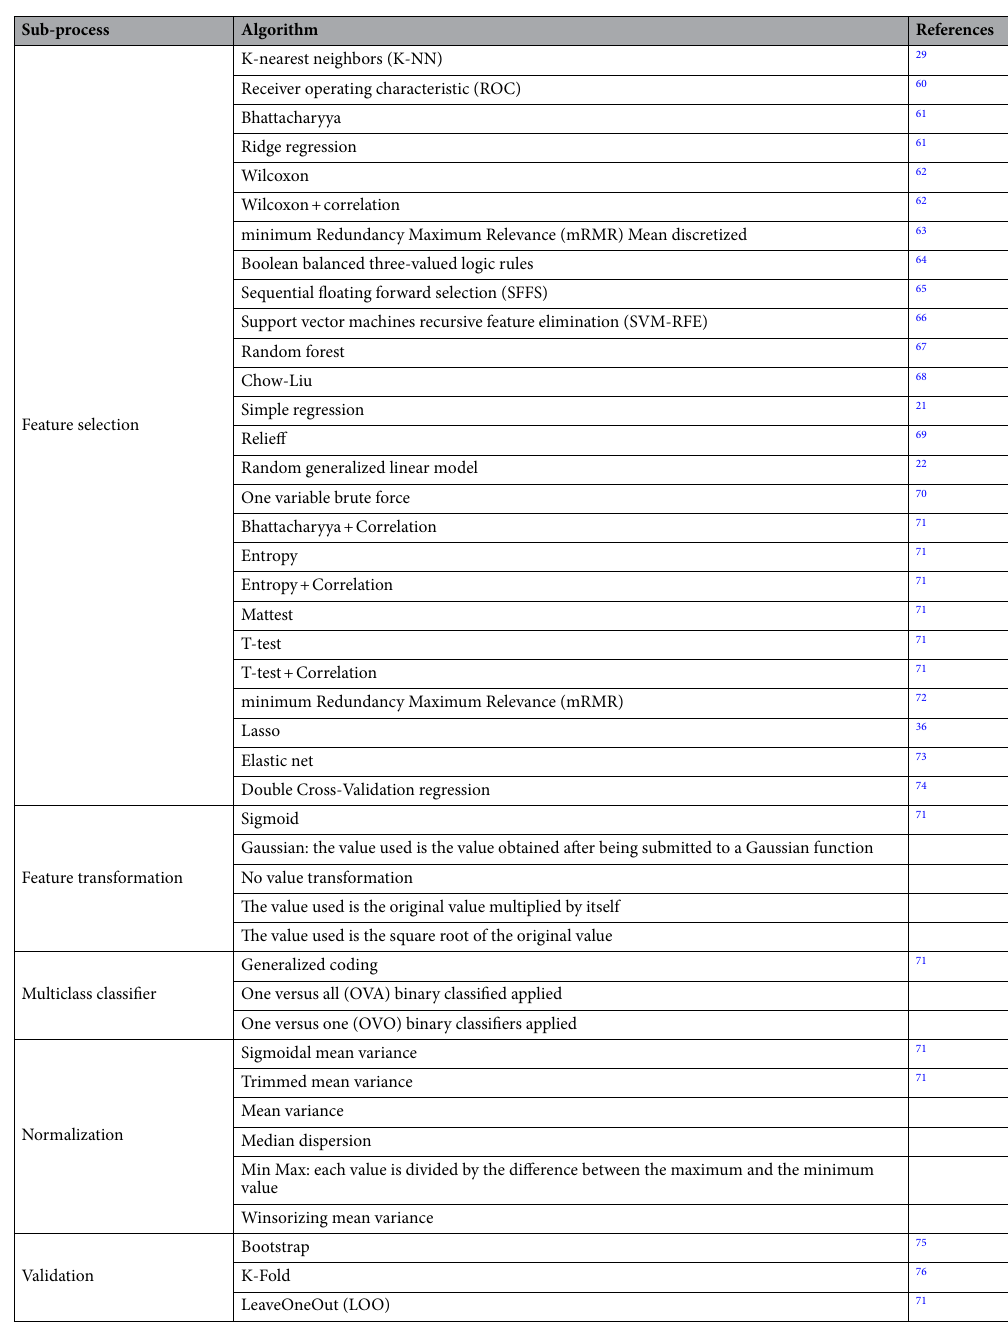
Gaussian: the value used is the value obtained after being submitted to a Gaussian function